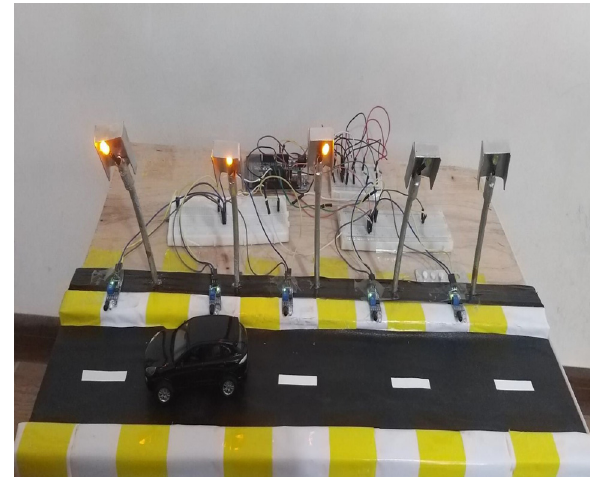
Figure 4: Switching ON of the light column nos. 3, 4, and 5, while 1 and 2 are